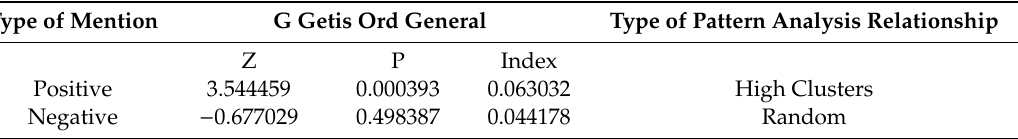
Table 10. G Getis Ord test on Hotels.